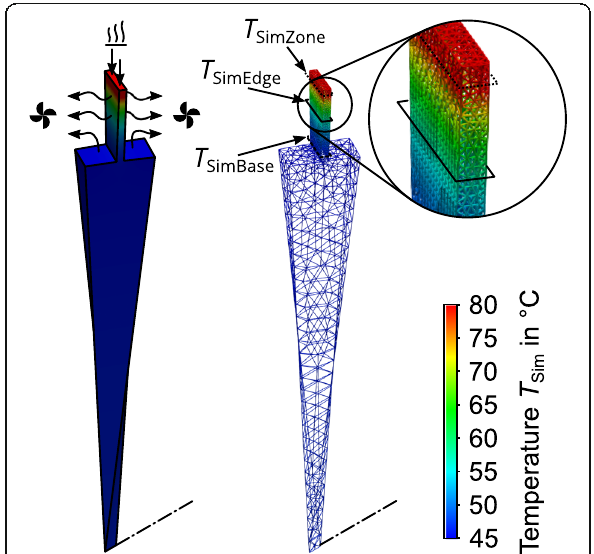
Fig. 8 Surface plot of a simulation step for the reduced model of the kniferoller with symbols for heat input and convection (left). The temperatures are evaluated on three levels in the wireframe model of the mesh resolution